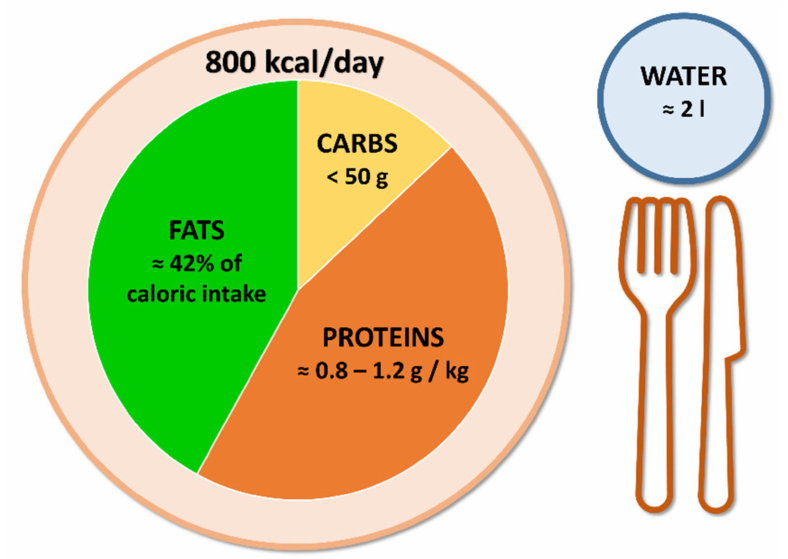
Figure 1. Very-low-calorie ketogenic diet